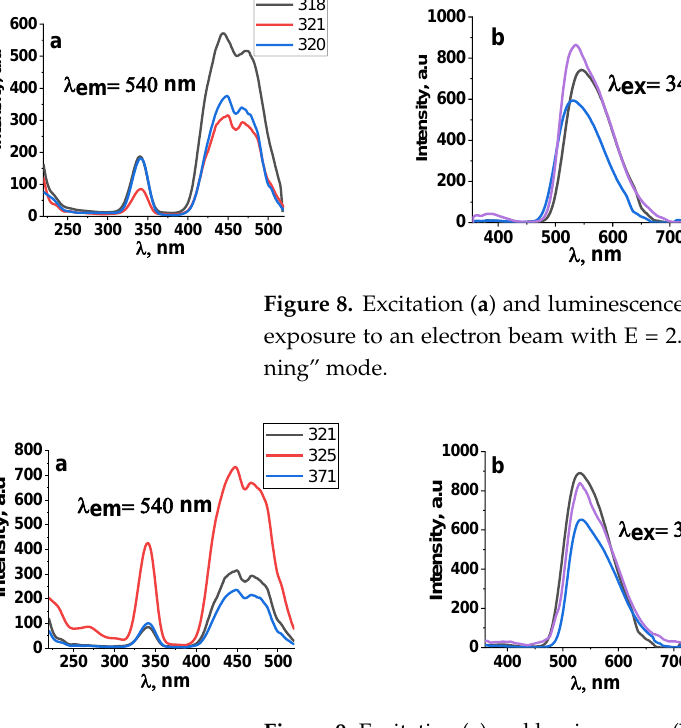
Figure 9. Excitation ( a ) and luminescence ( b , c ) spectra of ceramic samples synthesized when exposed to an electron beam with E = 1.4, 2.0, 2.5 MeV and P = 25, 33, 37 kW/cm 2 in “with scanning” mode.